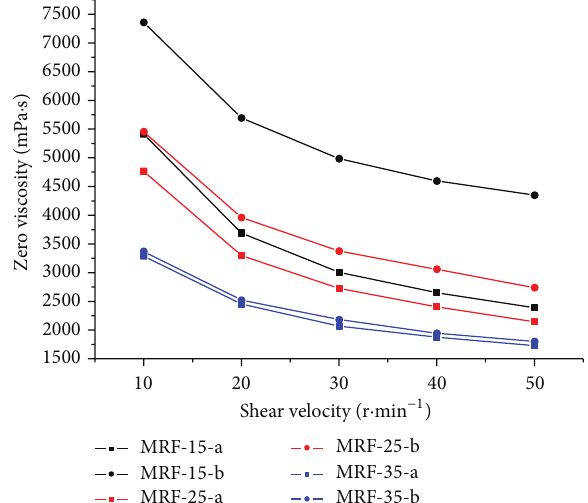
Figure 6: Zero-field viscosity of MRF under different shear